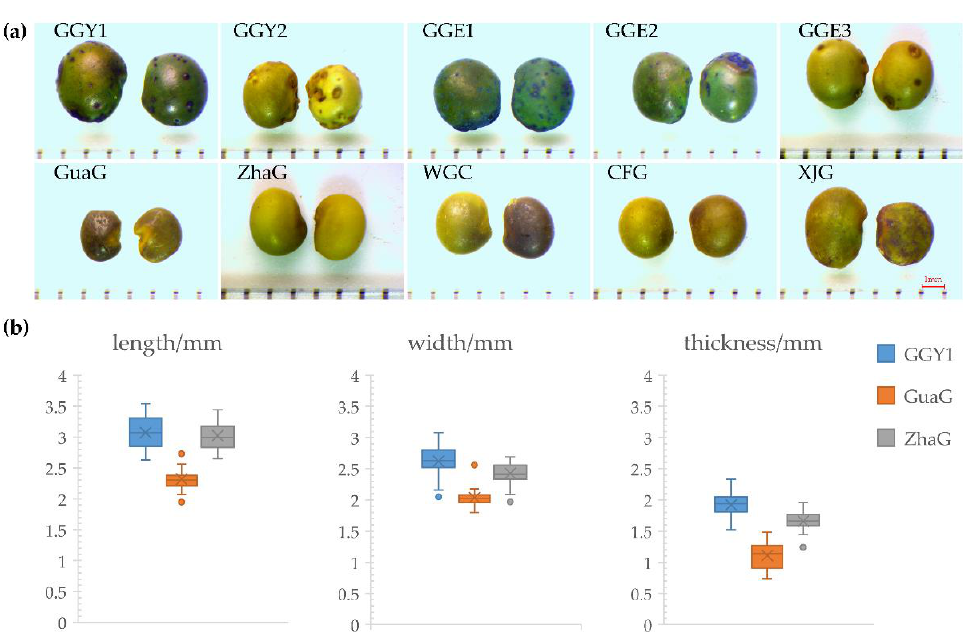
Figure 1. Morphology and size statistics box diagram of licorice seeds. ( a ) Morphology of ten samples of licorice seeds. One grid below the seed’s ruler indicates 1 mm. ( b ) Statistical graphs of the length, width, and thickness of 30 licorice seeds, respectively. Different colored boxes represent other species: the blue box is sample GGY1, representing G. uralensis ; the orange box is sample GuaG, representing G. glabra ; and the grey box is sample ZhaG, representing G. inflata. Compared to G. uralensis , the seed size and color of the seed coat are more varied. For instance, G. glabra and G. inflata are more uniform in seed size and episperm color.